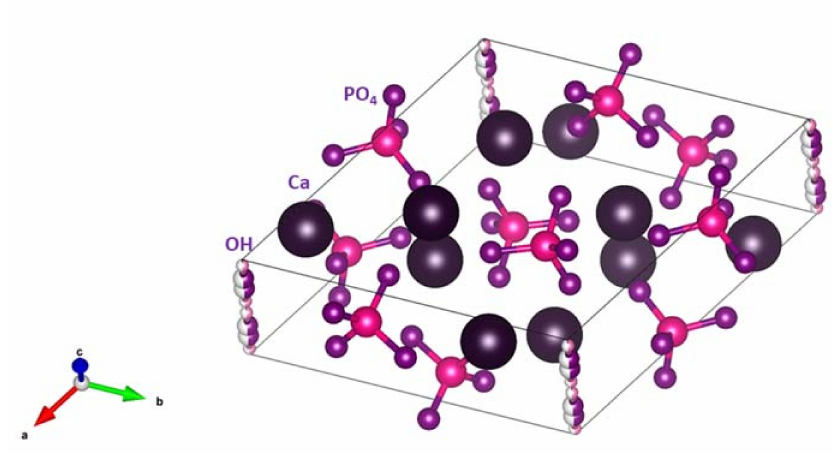
Figure 1. Crystallographic structure of